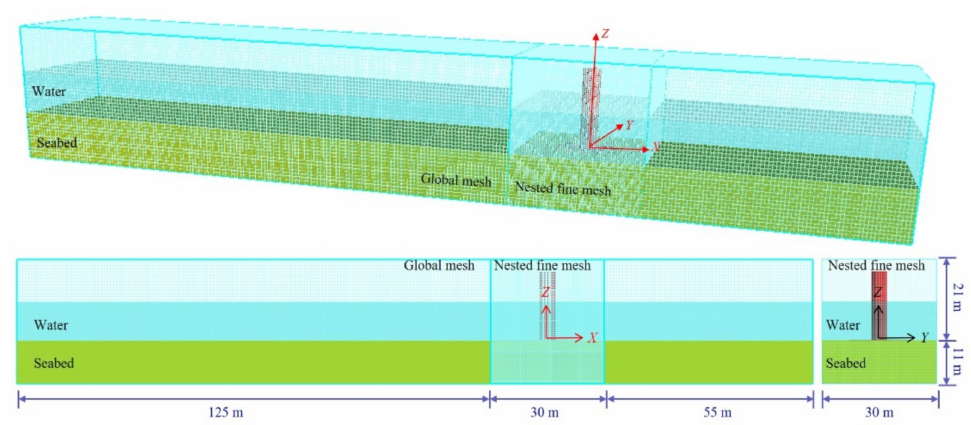
Figure 3. The sketch of mesh